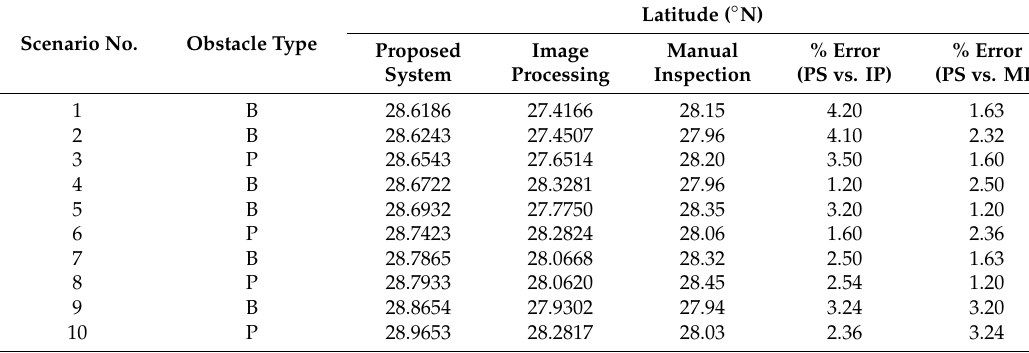
Table 14. Comparison of longitude between the proposed system (PS), image processing (IP), and manual inspection (MI) for the R2 test site.